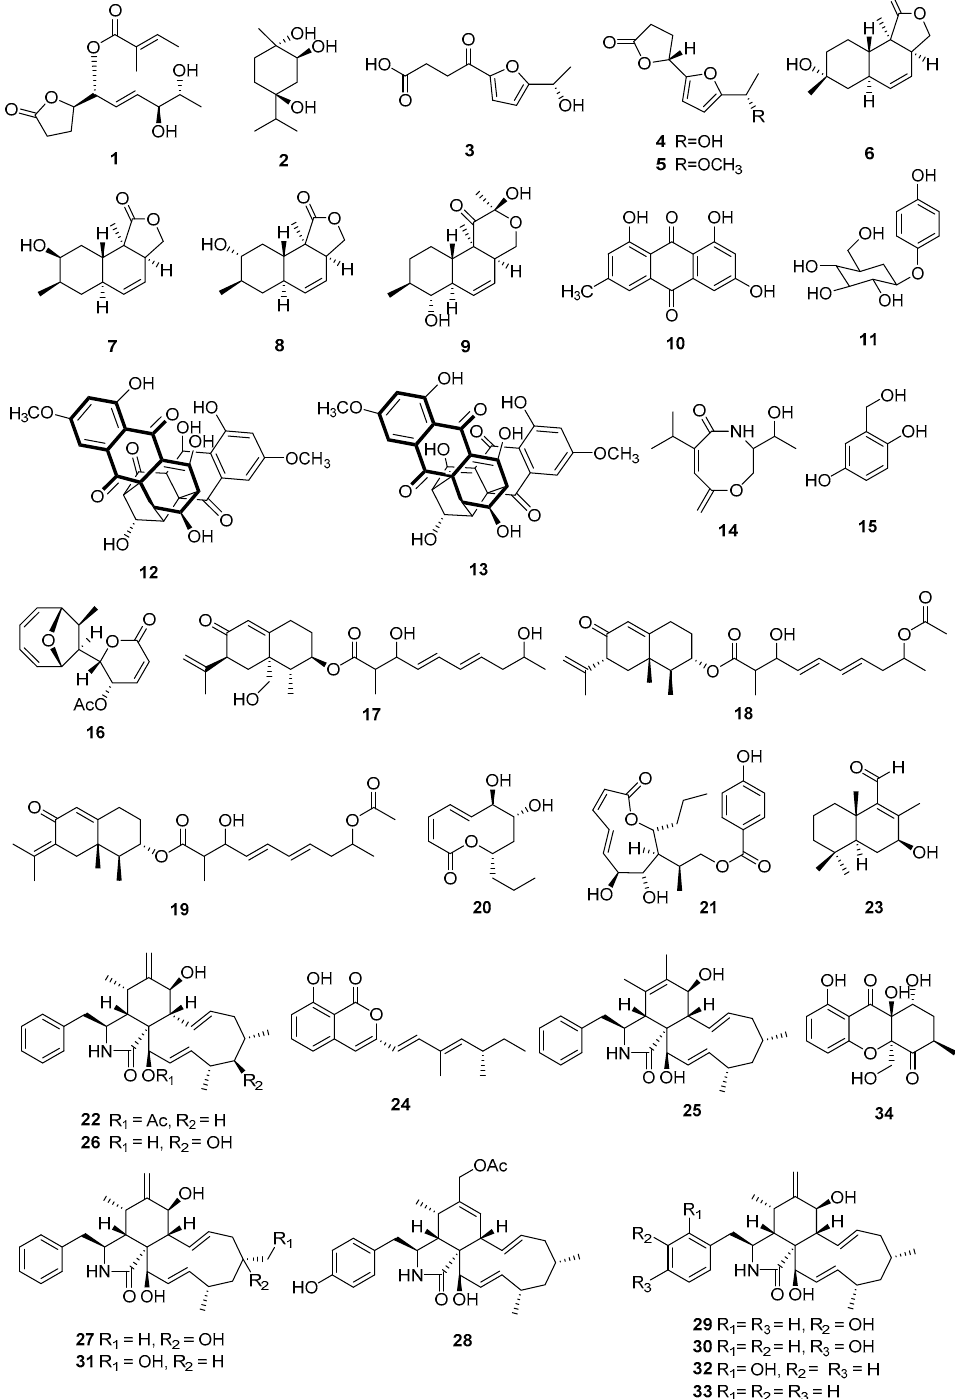
Figure 1. Chemical structures of compounds 1 – 34 of terrestrial